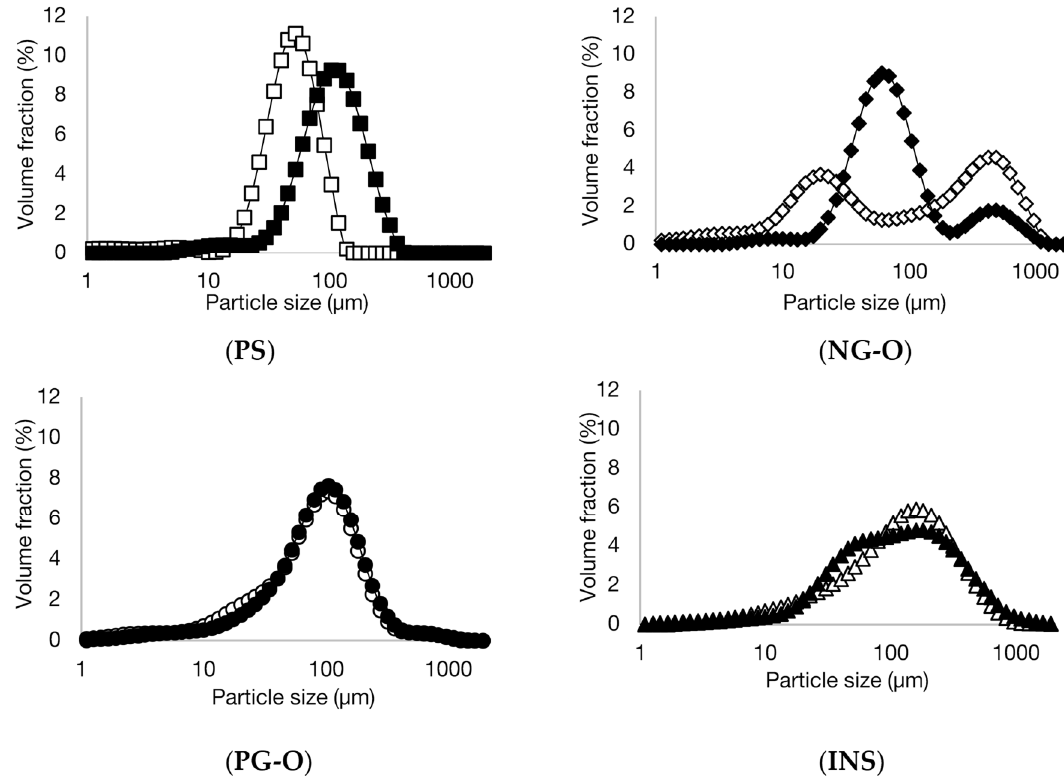
Figure 1. Volumetric particle size distributions of potato starch (PS), non-gelatinised open cell flour (NG-O), pre-gelatinised open cell flour (PG-O), and pre-gelatinised commercial chickpea flour (INS) suspended in cold (20 ◦ C) (open symbols) and boiling (100 ◦ C) (closed symbols) water.